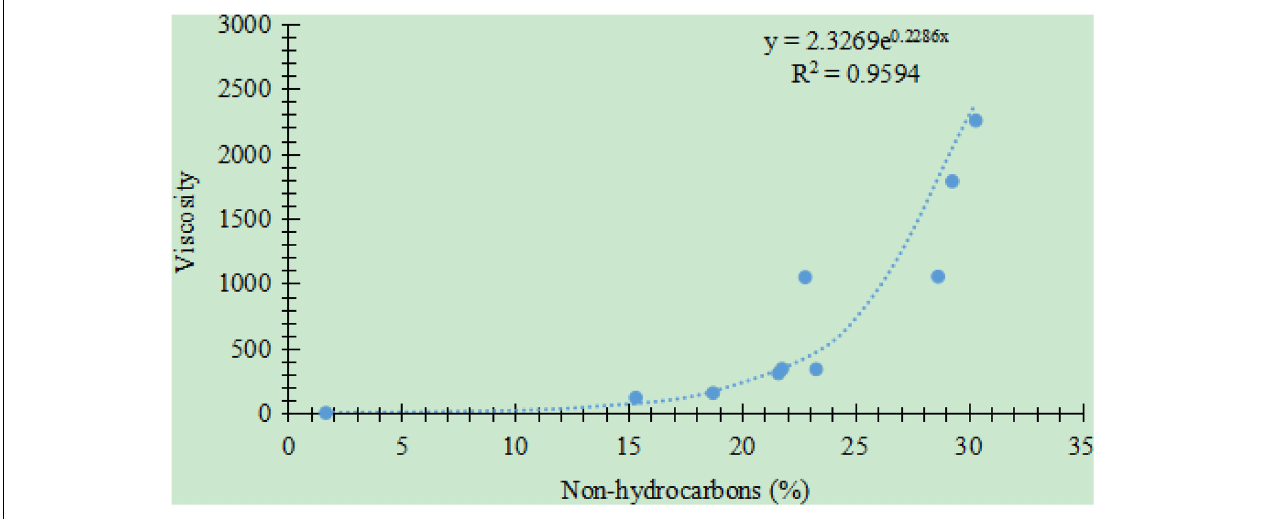
FIGURE 6 | Relationship between the content of the non-hydrocarbon and the viscosity (20 ◦ C) for crude oil extracted from the Jimsar Sag (the crude oil data were provided by the Xinjiang Oilfield Company of CNPC).